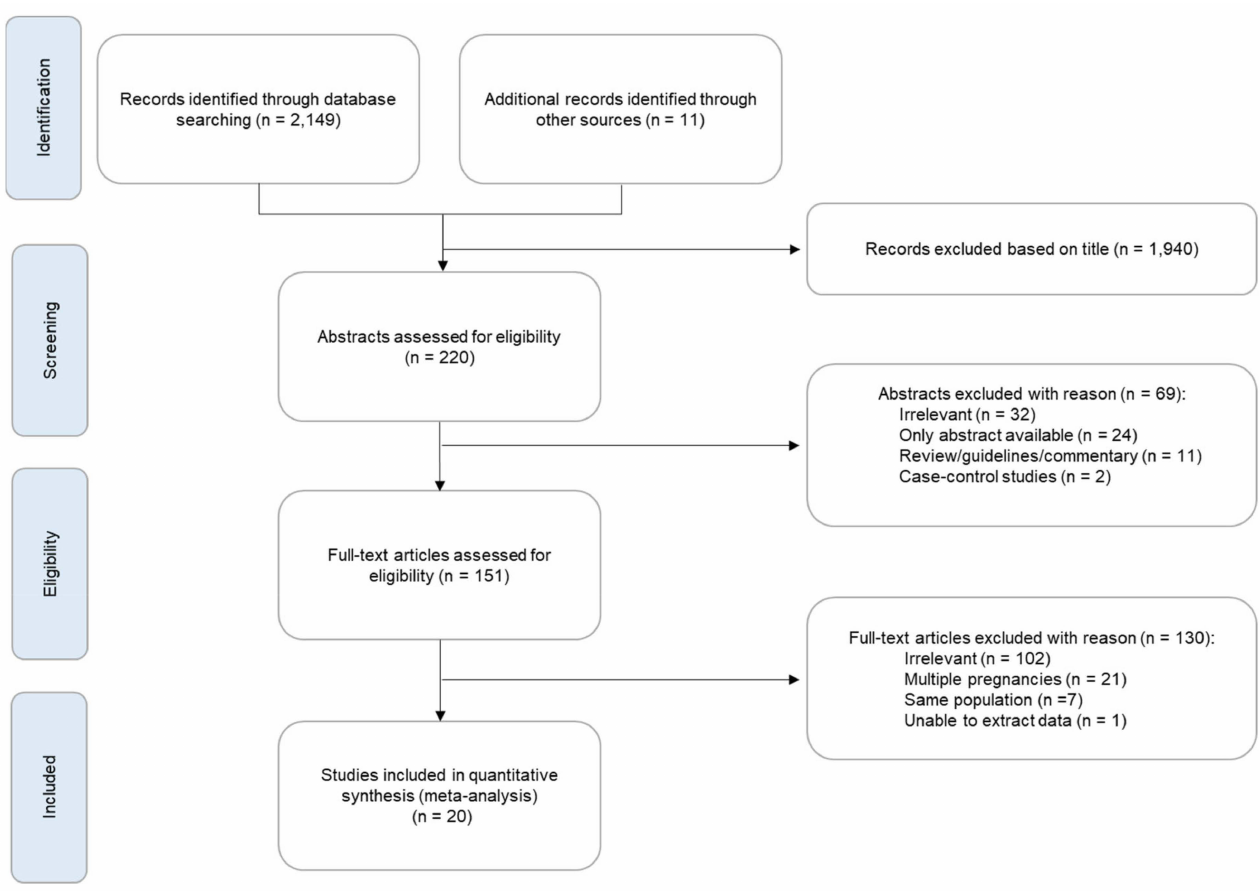
Figure 1. Flow chart for the systematic